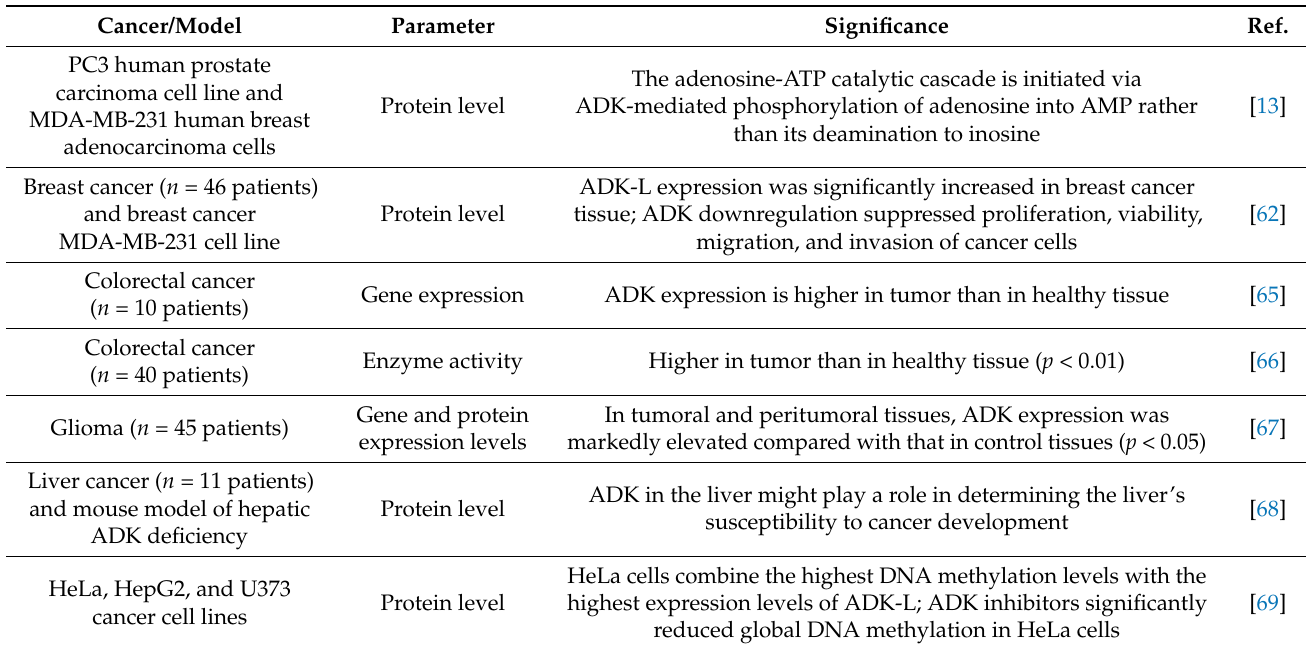
Table 2. The role of ADK in